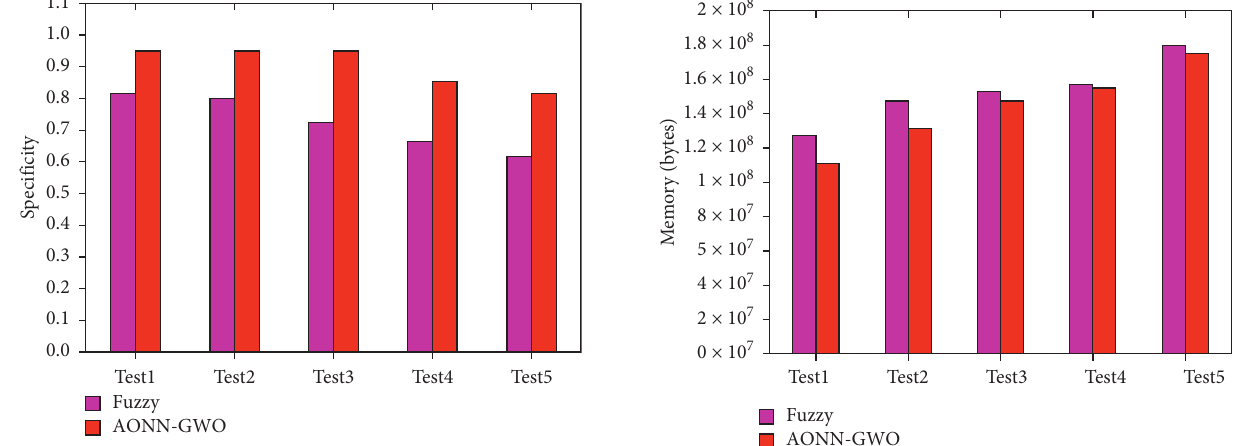
Figure 6: Comparative analysis of specificity result.